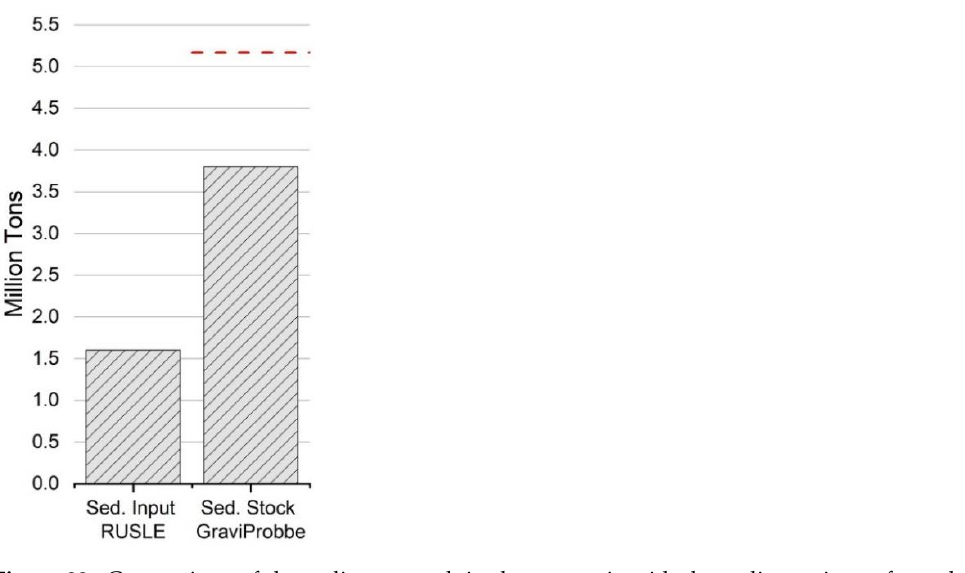
Figure 22. Comparison of the sediment stock in the reservoir with the sediment input from the catchment. The dashed line shows the margin of error as described in [12]. Table 5. Overview of factors creating inconsistencies.